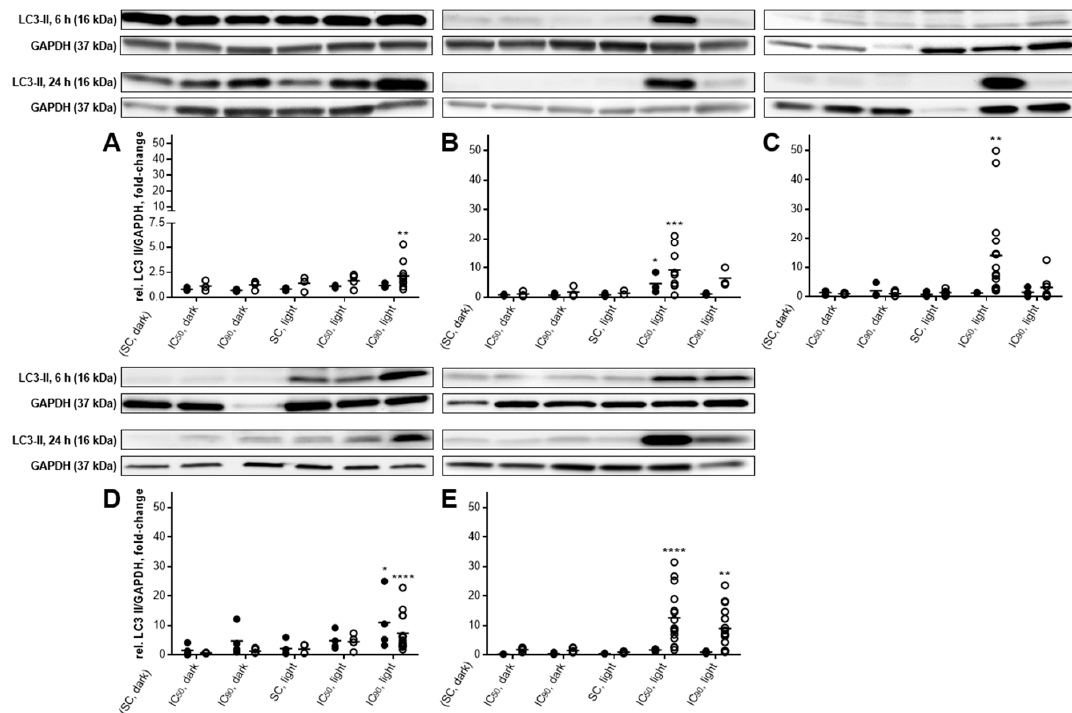
Figure 10. Formation of LC3-II in A-427 (A), BHY (B), KYSE-70 (C), RT-4 (D) and SISO (E) cells after